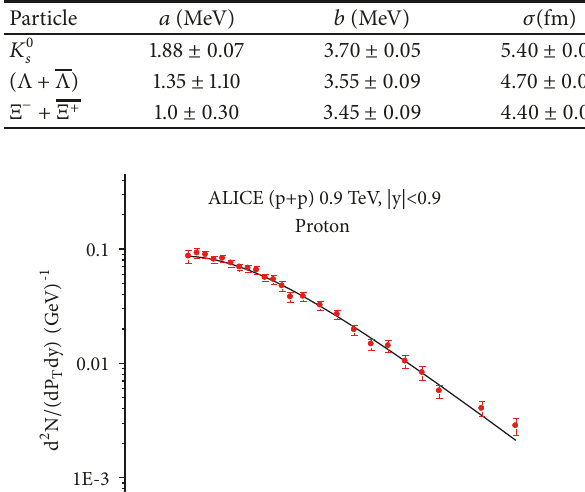
Table 1: Values of a, b, and 𝜎 obtained from fitting the rapidity distributions of 𝐾 0 𝑠 , (Λ + Λ) , and (Ξ − + Ξ − ) , respectively, at √ s NN = 0.9 TeV.